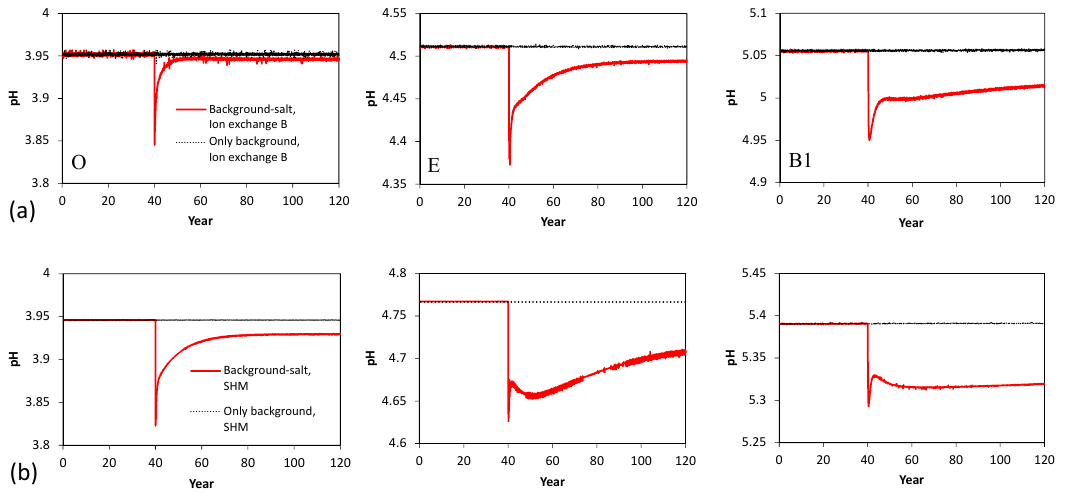
Figure 4. Simulated pH values following a permanent increase of the sea salt deposition after 40 years. The atmospheric deposition during years 0 to 40 (to 120 for the control simulation) was the estimated one at 1880 for the Gårdsjön site. (a) Results obtained with the ion- exchange model B, and (b) results obtained with the SHM.